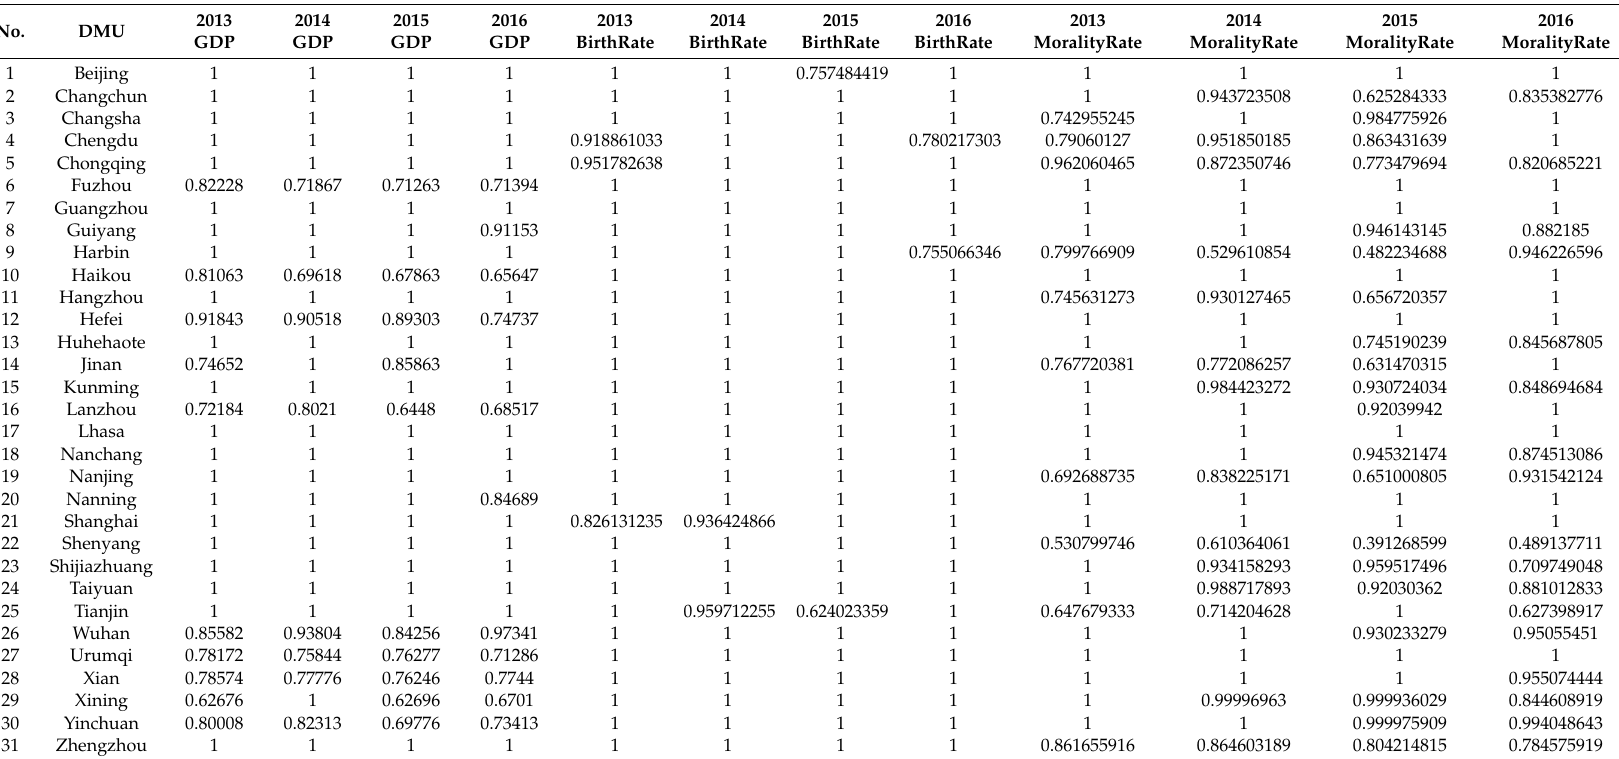
Table 6. GDP, Birth rate and Mortality rate e ffi